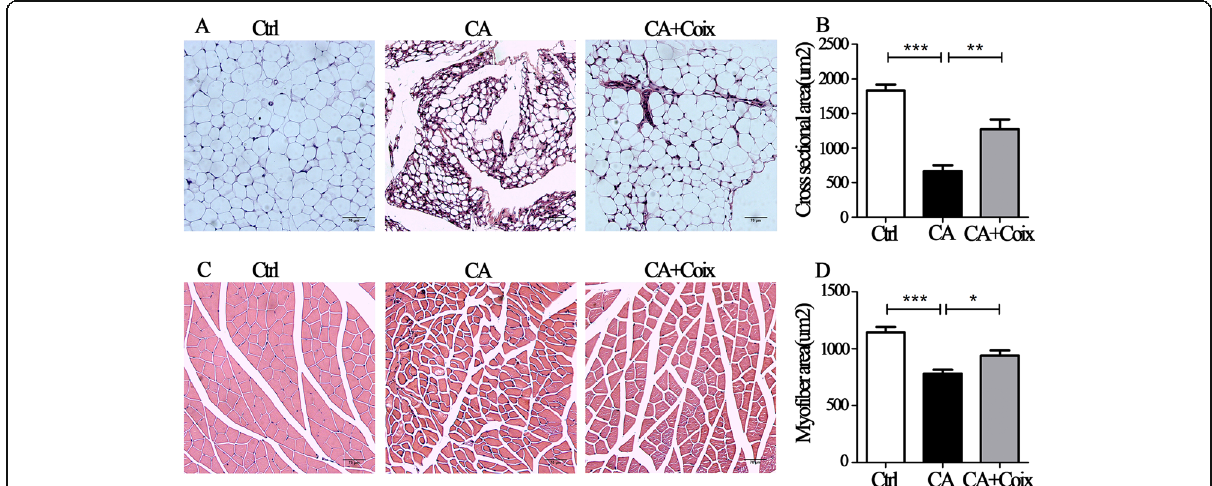
Fig. 3 CSO attenuated muscle fiber atrophy and adipose tissue wasting induced by cancer cachexia. a . Representative figures of HE staining of epididymal adipose tissue in three groups (Ctrl, CA, CA + Coix). b .The quantitative comparison of cross-sectional area (um 2 ) of adipocytes between three groups (Ctrl, CA, CA + Coix) revealed that CSO administration counteracted adipose tissue wasting. c . Representative cross- sectional histological staining of muscle fiber in three groups (Ctrl, CA, CA + Coix). d .The quantification of myofiber cross-sectional area showed that CSO administration attenuated muscle fiber atrophy. Values were expressed as mean ± SEM (* P <0.05, ** P <0.01, *** P <0.001)